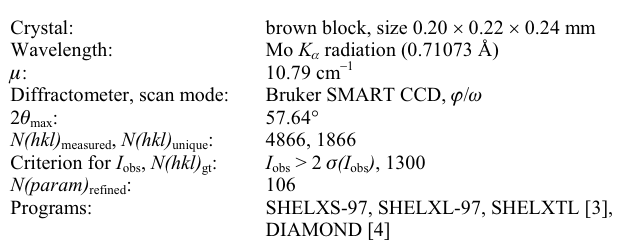
Table 1. Data collection and handling.